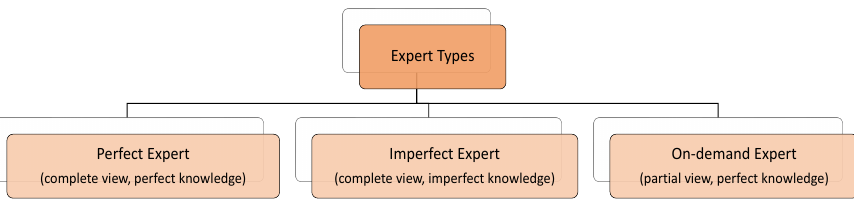
Figure 3. Different types of experts in a multi-expert setting in an M-health